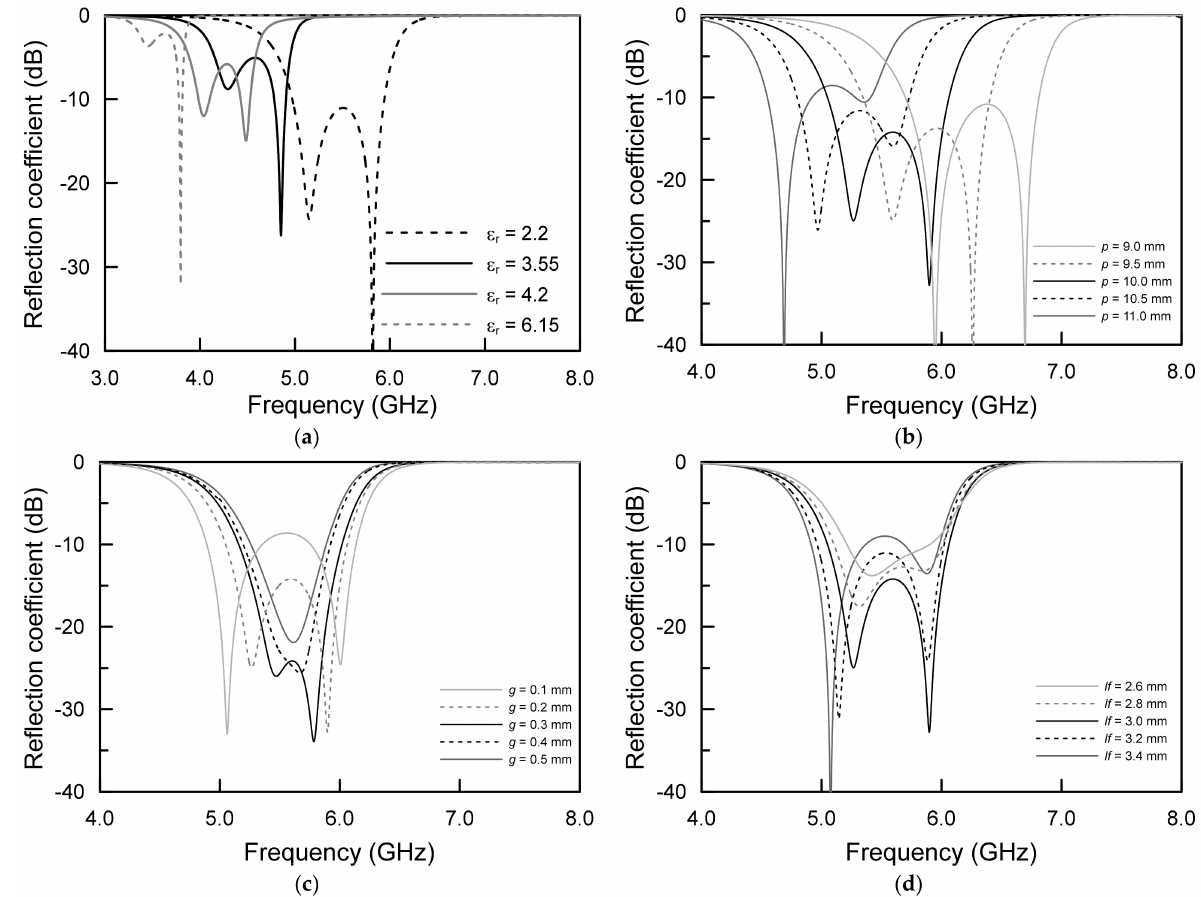
Figure 4. Simulated results of the proposed antenna: ( a ) relative dielectric constant, ( b ) feed size, ( c ) gap size and ( d ) ground soldering